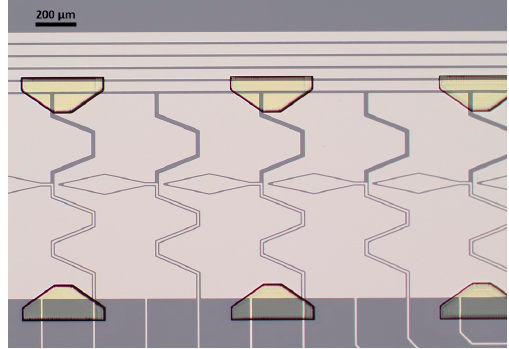
Figure 20. Physical photoresist barriers with a height of approximately 9 µ m. Neither the five segmented finger electrodes to the side nor the electrodes in the center of the structure are relevant for the long stroke actuation.